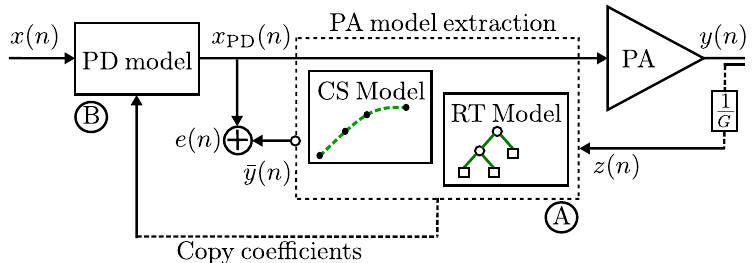
Figure 10. An extract feature block model approach for the PA (connections model referred to a feature surrogate dependent on a complex input envelope with an indirect learning approach). ( A ) denotes the PA model extraction and, ( B ) the PD construction